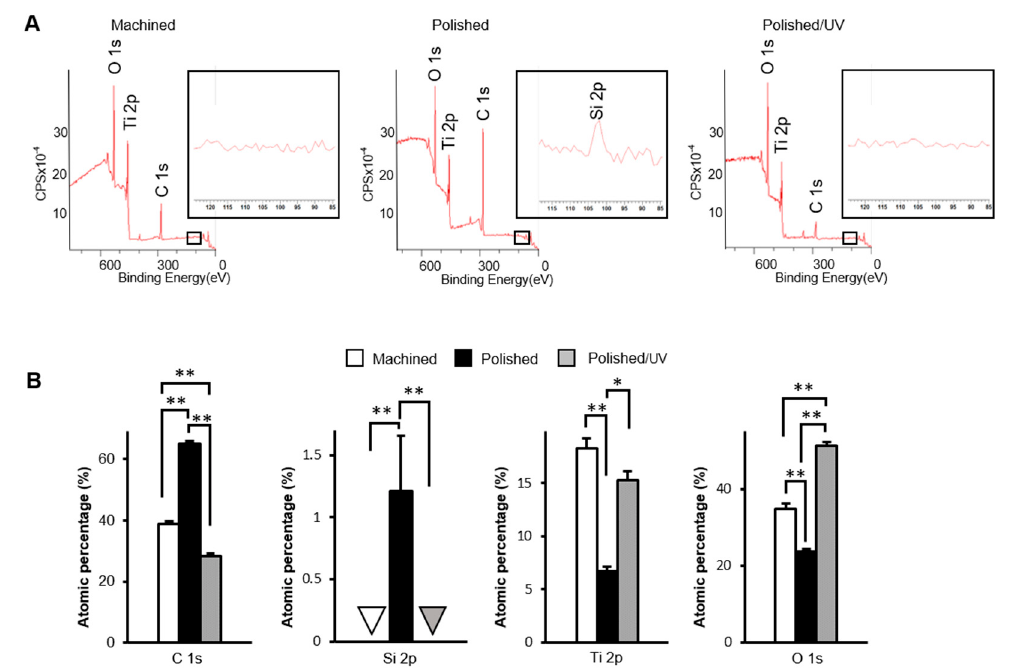
Figure 4. Physicochemical evaluation of titanium surfaces. The X-ray photoelectron spectroscopy (XPS) analysis of the machined surface, polished surface and polished / UV surface (* p < 0.05, ** p < 0.01). ( A ) Wide-scan spectrum for each samples; ( B ) Calculated atomic percentage of C1s, Si2p, Ti2p and O1s.